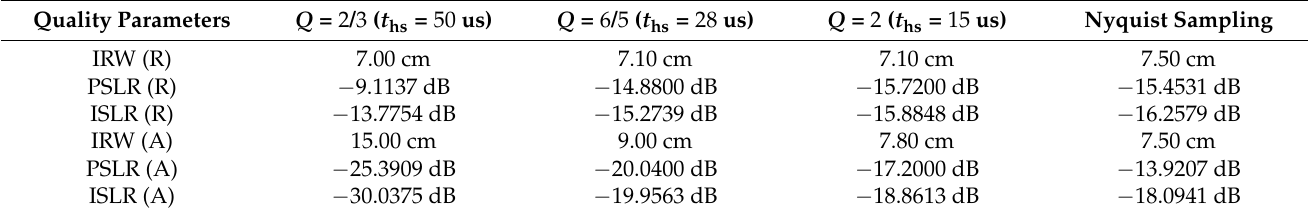
Table 4. The analysis of imaging quality for single point target with different factors.